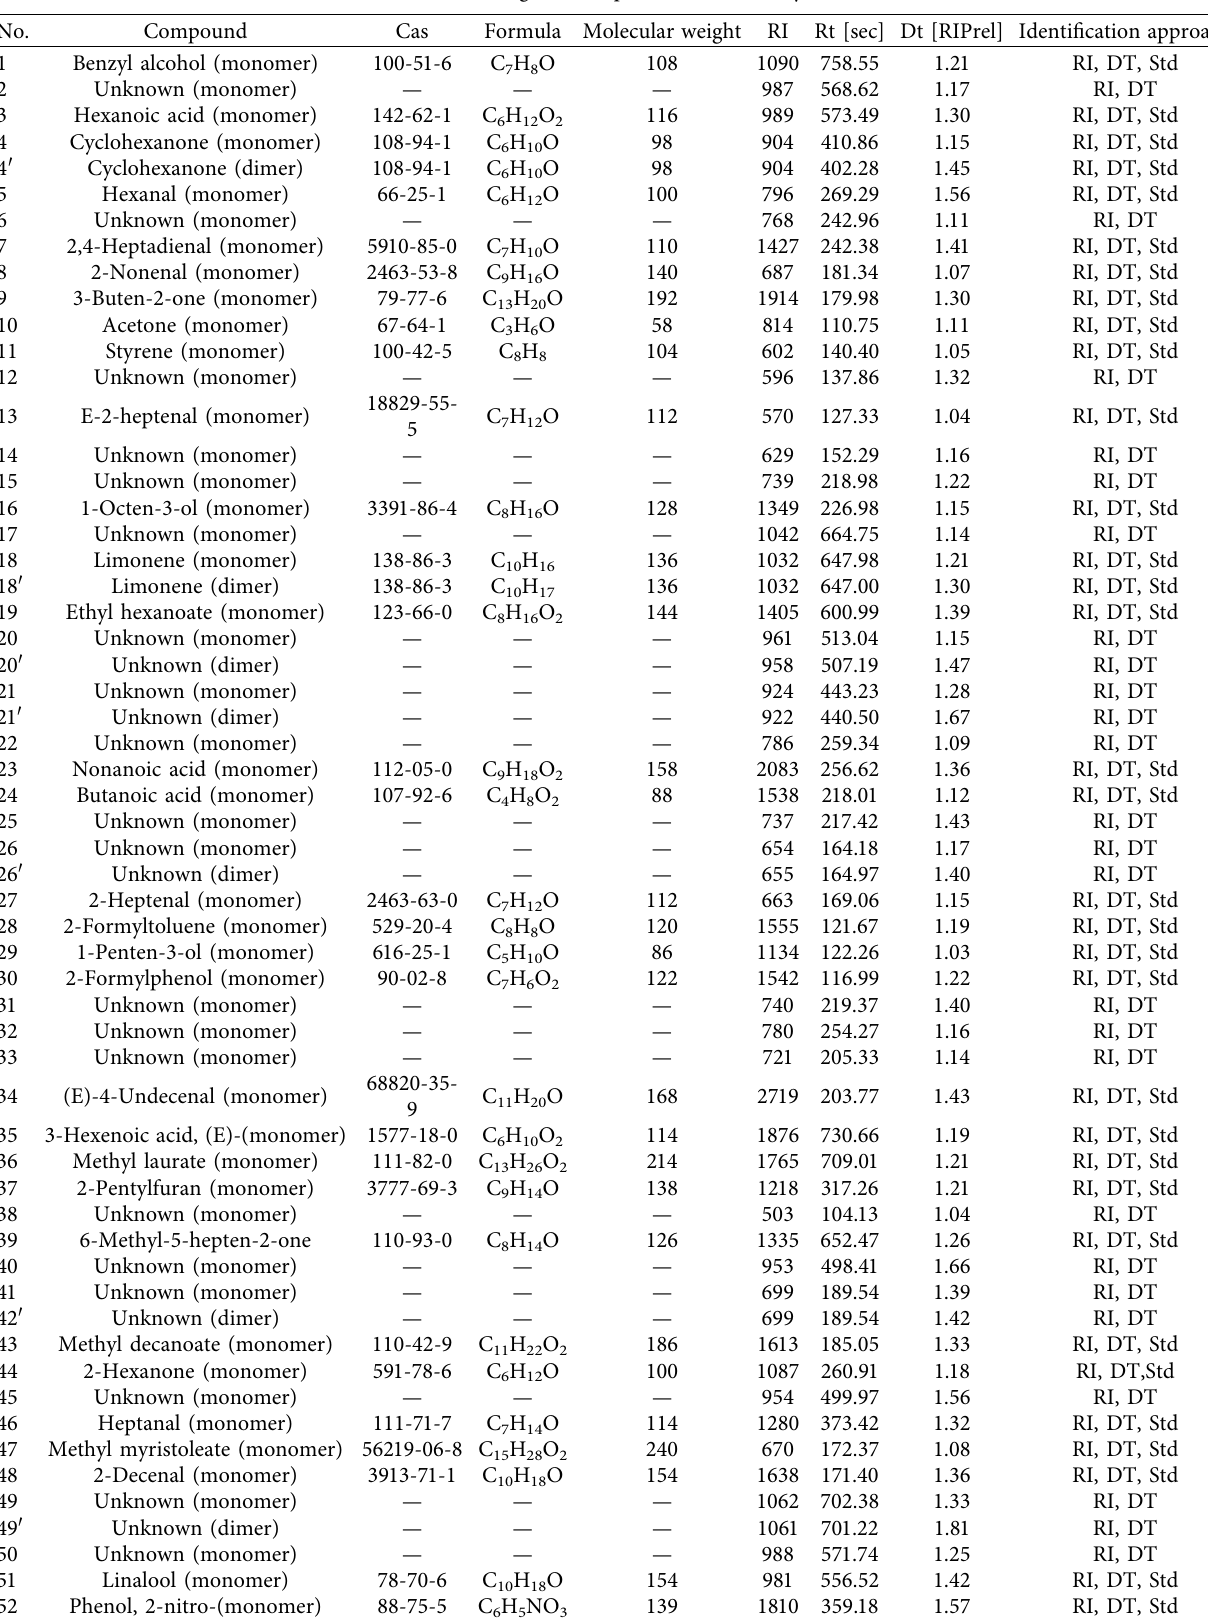
Table 2: Volatile organic compounds identified by